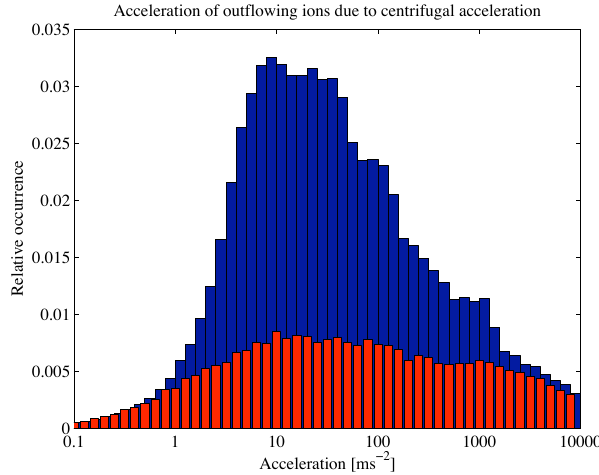
Fig. 4. Distribution of the total centrifugal acceleration for all valid measurement points in the statistical study, for three different K p intervals. The x-axis shows the acceleration [ ms − 2 ] , the y-axis shows the relative occurrence for positive (increased outflow velocity, blue bars) and negative acceleration (decreased outflow velocity, red bars). The red bars are shifted half a bin towards lower values to increase readability. The upper panel shows the results for K p < =2, the middle panel shows the results for K p > 2 , K p < 5 and the lower panel shows the result for K p > = 5 . The number of data points included in each interval is given in the text above each panel.